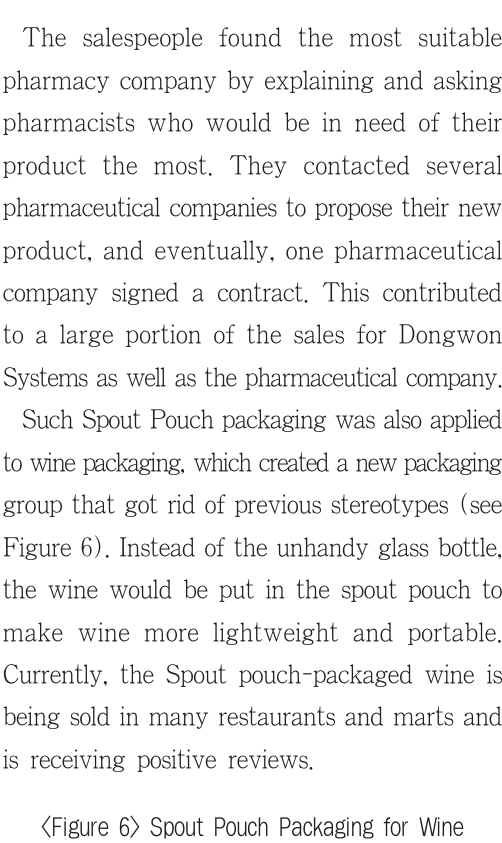
<Figure 6> Spout Pouch Packaging for Wine